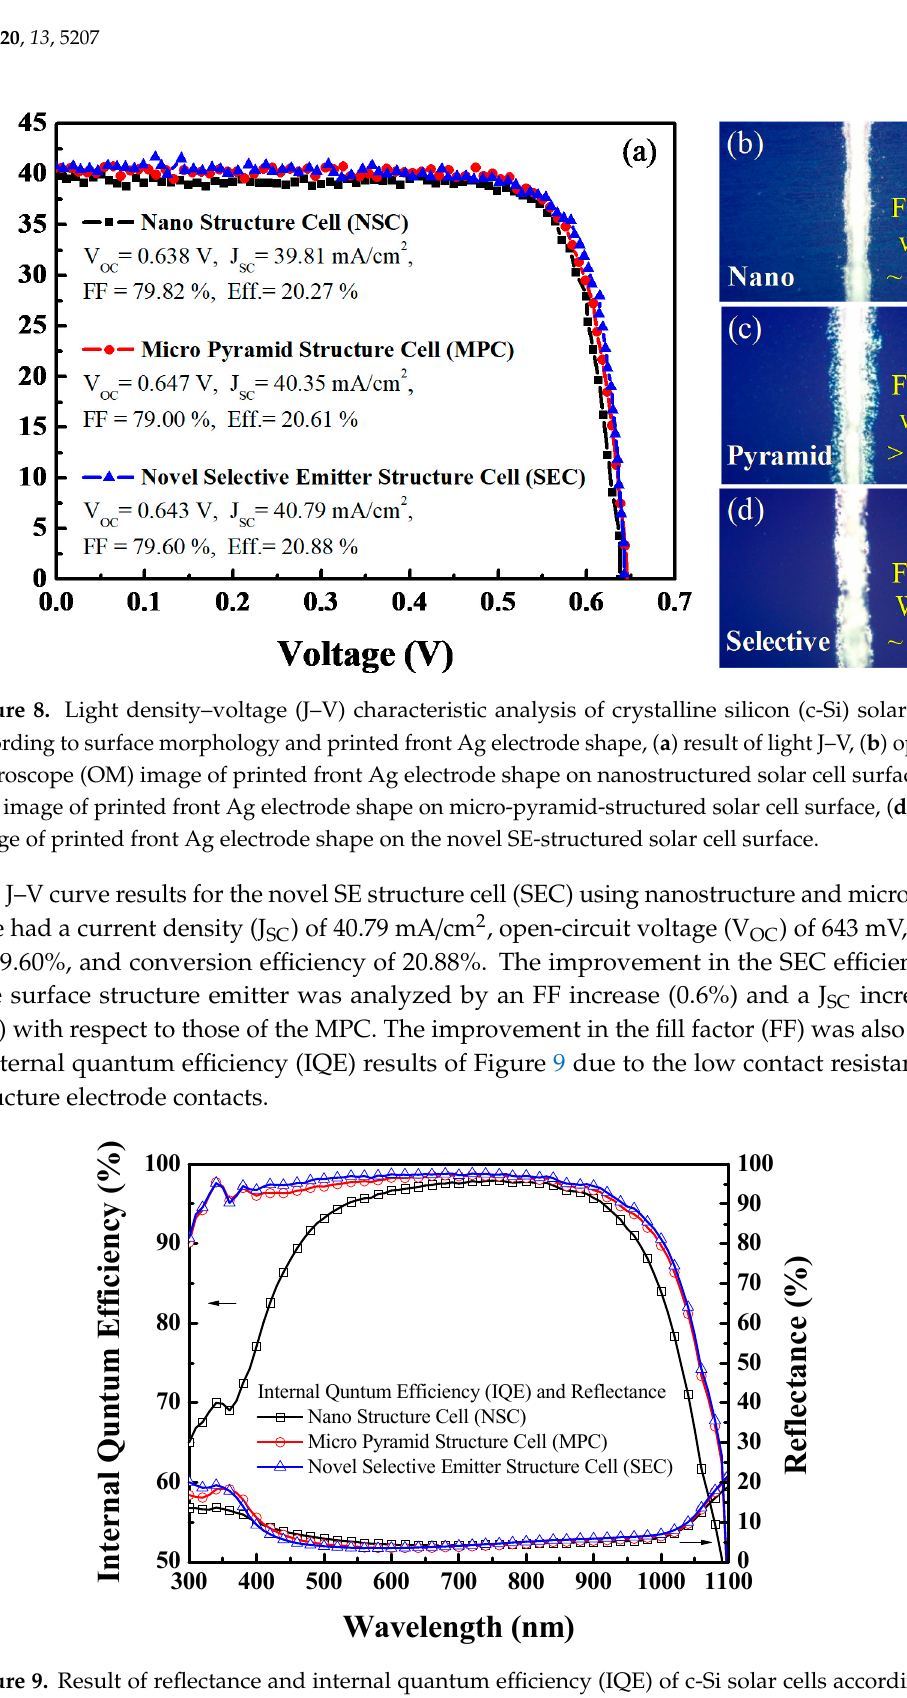
Figure 9. Result of reflectance and internal quantum e ffi ciency (IQE) of c-Si solar cells according to surface